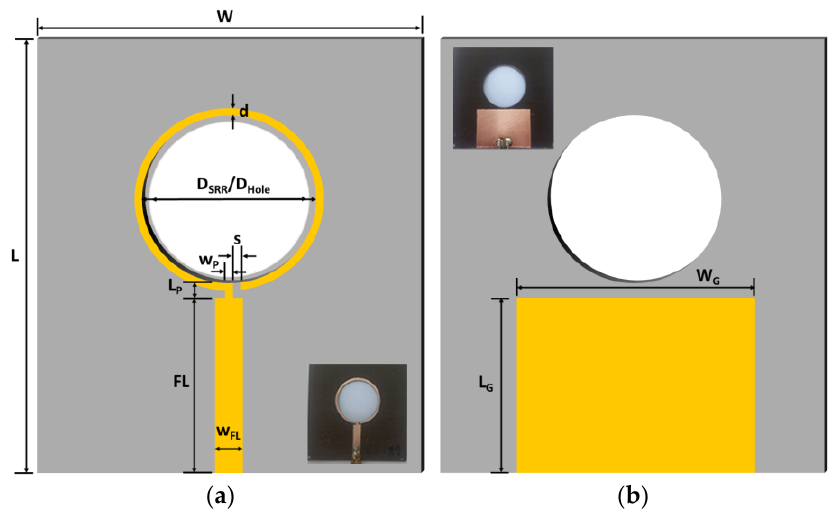
Table 1. Geometrical parameters of a microwave sensor.